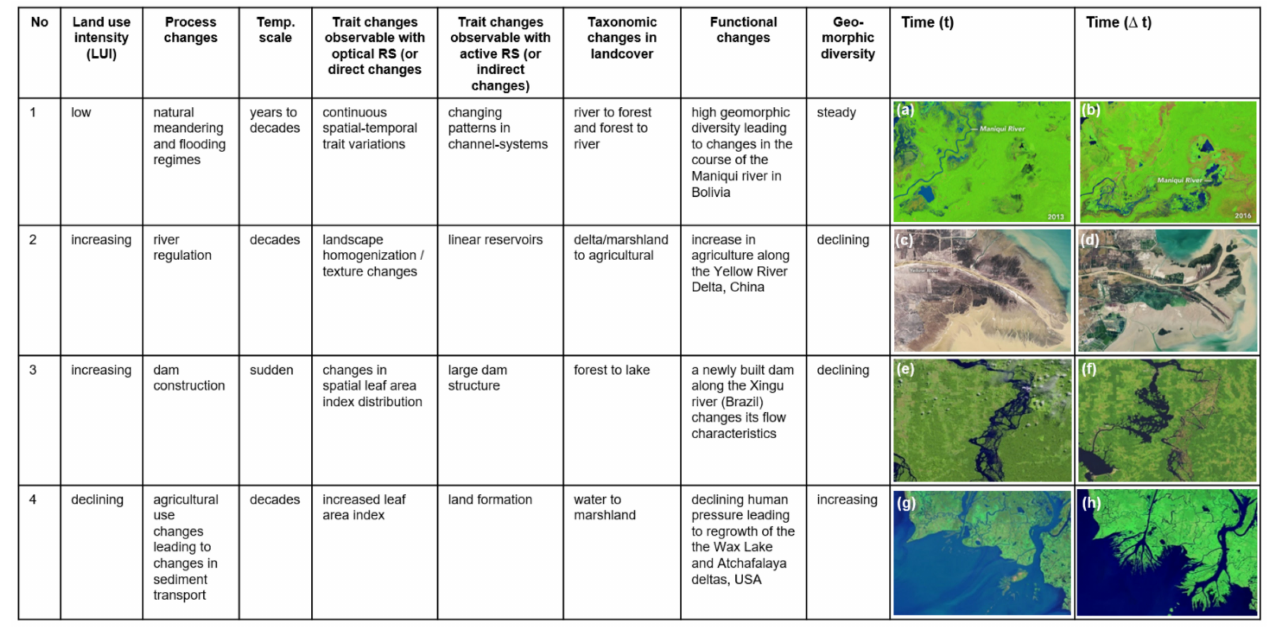
Figure 16. A selection of fluvial geomorphic processes/changes, caused by natural processes or declining and increasing human land-use intensity, with images recorded by Landsat optical remote- sensing missions. The changes lead to different traits and taxonomical changes and act on different time scales. Image sources: Landsat satellite images, (https://earthobservatory.nasa.gov/, (accessed on 5 January 2022)); ( a , b ); land-use intensity—low https://earthobservatory.nasa.gov/images/ 89266/a-shape-shifting-river-in-bolivia, (accessed on 5 January 2022); ( c , d ) land-use intensity— increasing; https://earthobservatory.nasa.gov/world-of-change/YellowRiver/show-all, (accessed on 5 January 2022); ( e , f ) land-use intensity—increasing, https://earthobservatory.nasa.gov/images/ 91083/reshaping-the-xingu-river, (accessed on 5 January 2022); ( g , h ) land-use intensity—declining, https://earthobservatory.nasa.gov/world-of-change/WaxLake, (accessed on 5 January